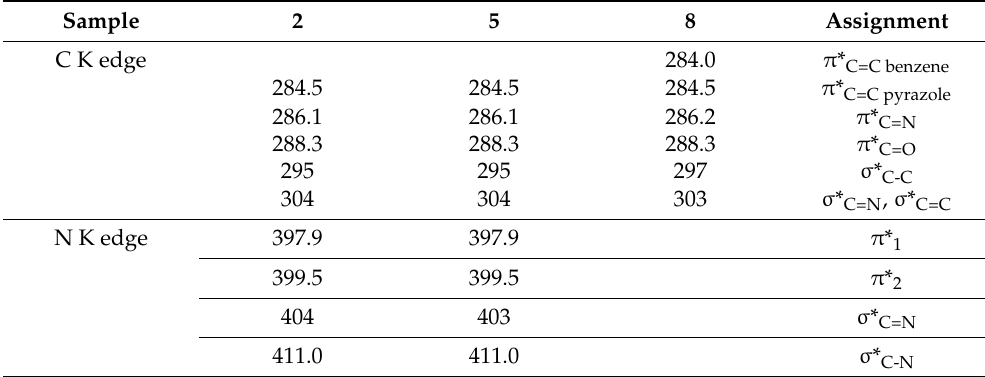
Table 1. Peak position (eV) and relative assignment of the main features appearing in the C K edge spectra of samples 2 , 5 , and 8 and in the N K edge NEXAFS spectra of samples 2 and 5 .